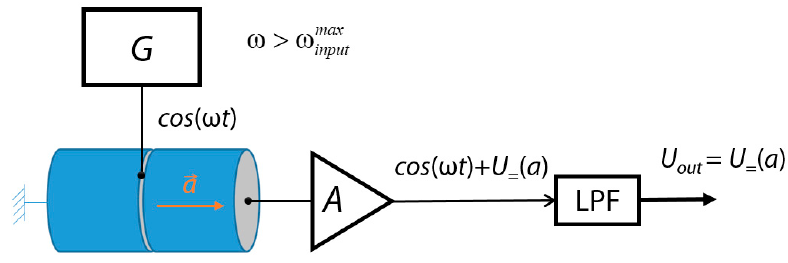
Figure 1. Design concept of a proposed microaccelerometer. G: generator; A: amplifier; LPF: low-pass filter.